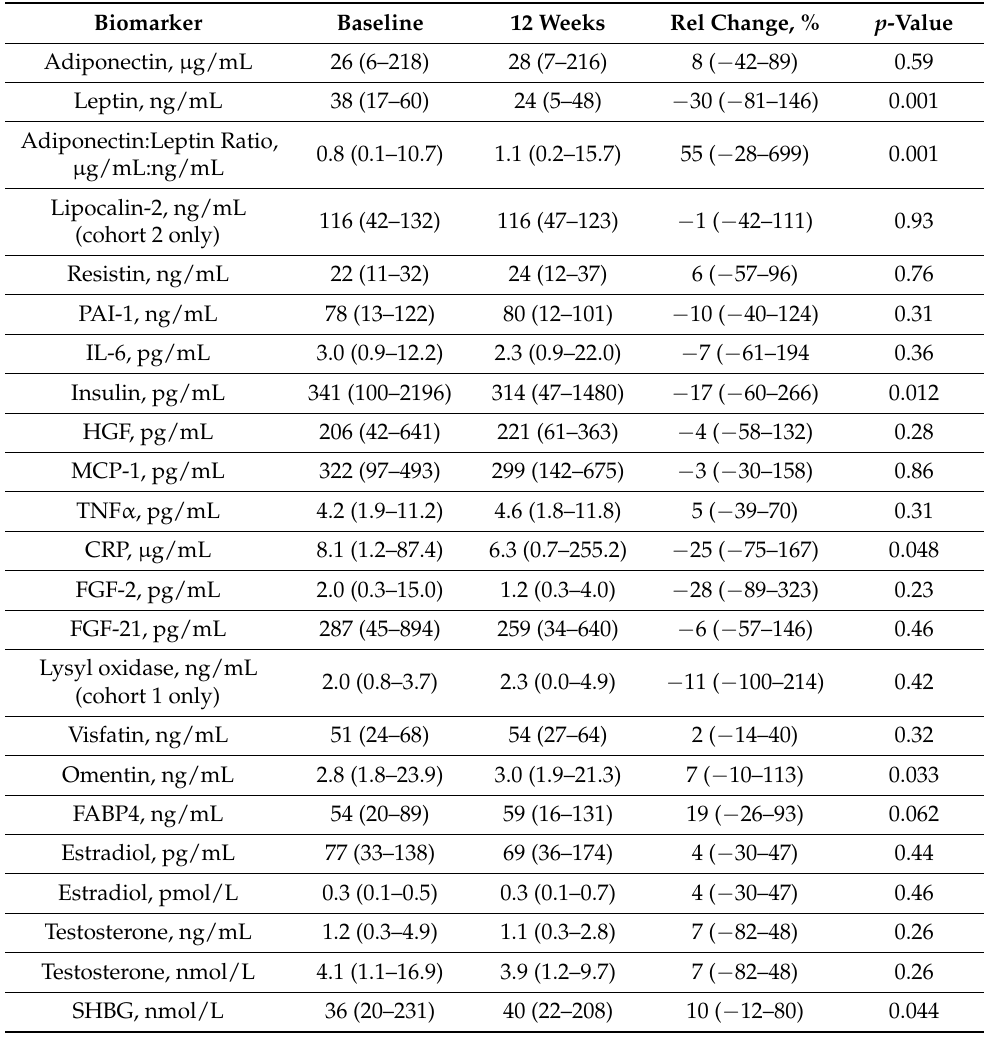
Table 5. Serum biomarker changes for 22 women completing the 12-week weight loss intervention. Median (range) values. p -values from Wilcoxon signed rank test,